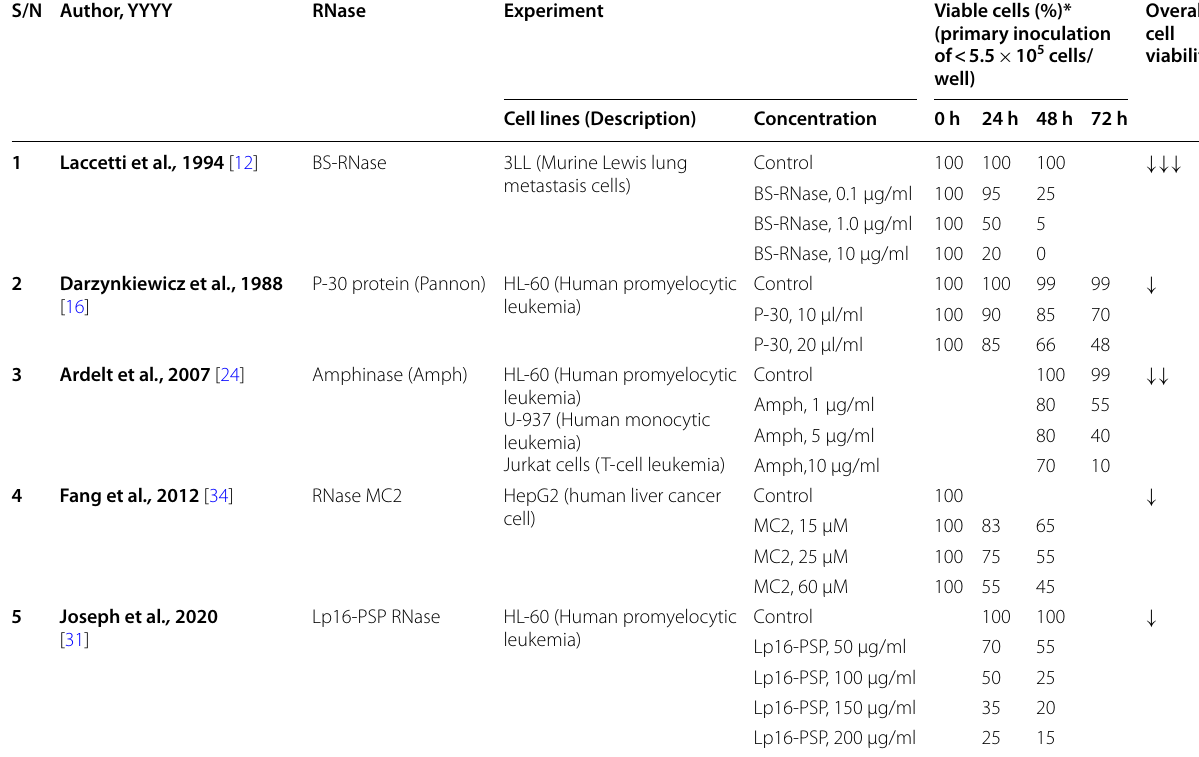
*Appropriate cell densities were initially seeded for each experimental cell model.